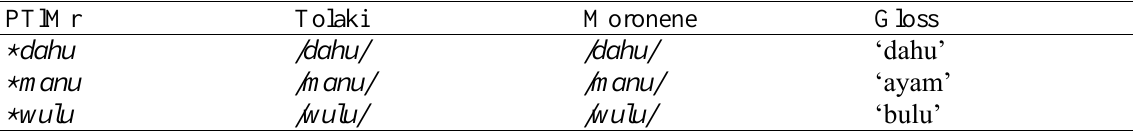
Table 10. The final Word Position of the word